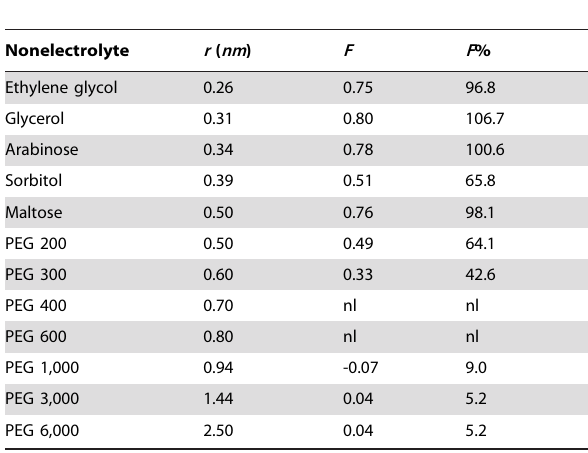
Table 2. Parameters for the filling of the P66 channel with nonelectrolytes.